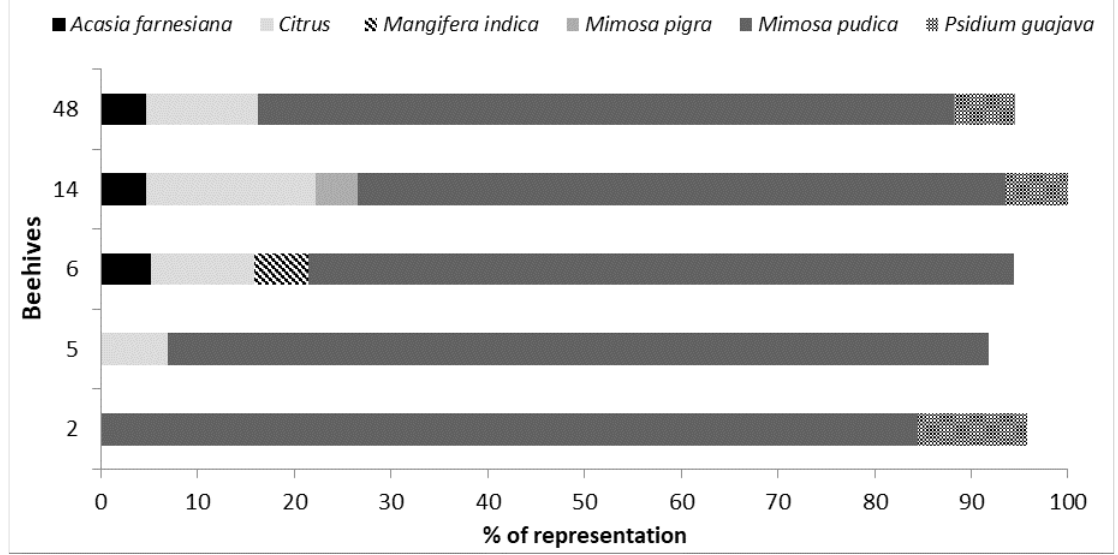
Fig 4. Main floral resources identified in the pollen collected from the Mayabeque province. Dominant pollen (> 45%), companion or secondary pollen (16-45%), isolated pollen